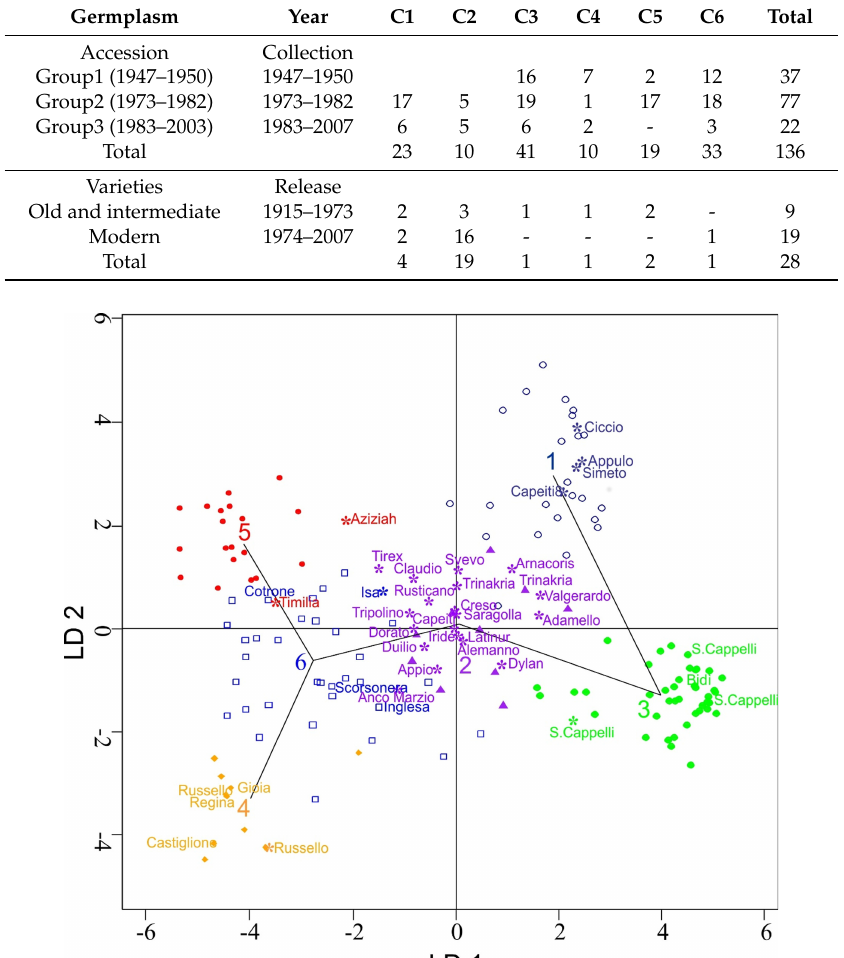
Figure 1. Scatterplot of the first two principal components of the DAPC applied on 136 ex situ accessions and 28 durum wheat varieties. Minimum spanning tree connects the six groups. Varieties (*) and named accessions are reported. Numbers and colors identify the clusters. LD: